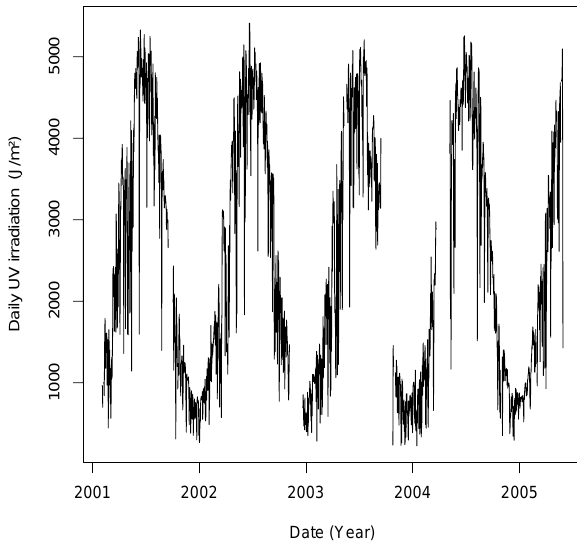
Fig. 1. Evolution of daily ultraviolet erythemal irradiation throughout the period of study.